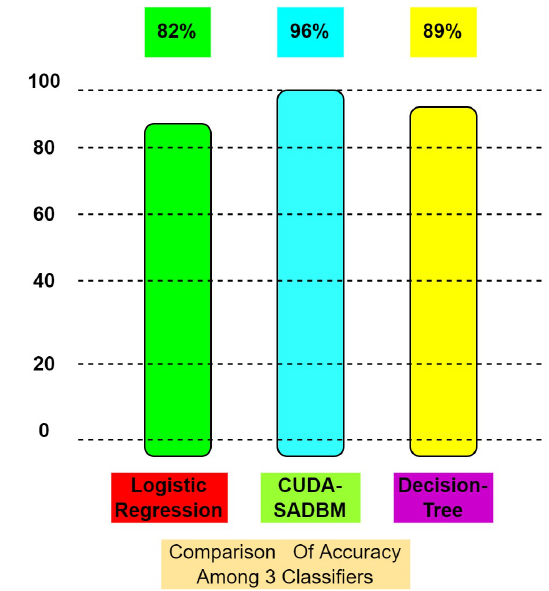
Figure 12. Comparison of 3